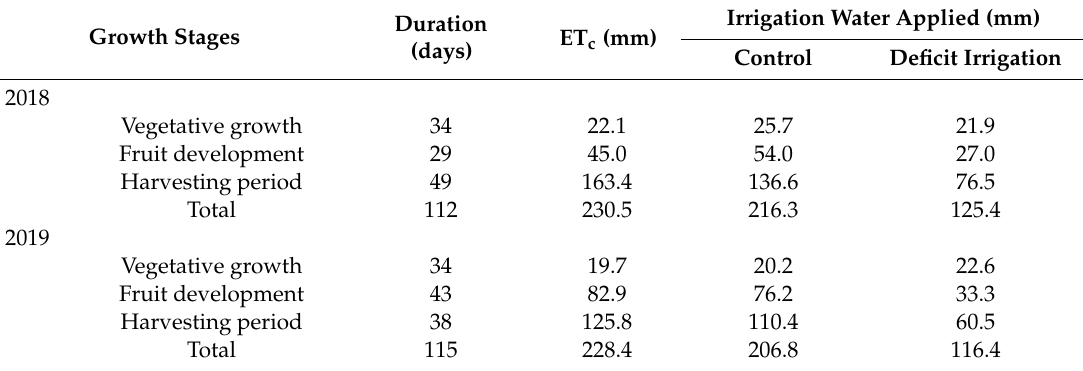
Table 1. Crop evapotranspiration (ET c ) and irrigation water applied in the di ff erent growth stages for the plants under the control and deficit irrigation conditions during 2018 and